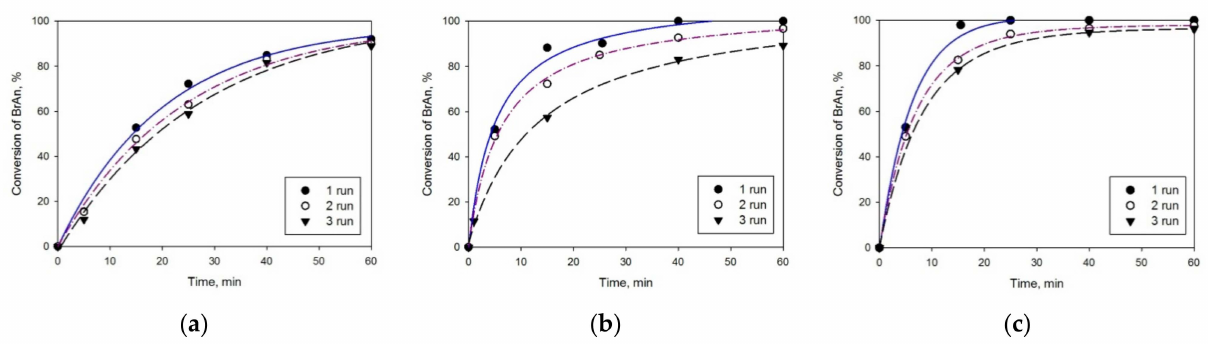
Figure 11. Influence of repeated runs on the dependence of BrAn conversion vs. time for 1%-Pd/HPS- R ( a ), 0.5%-PdAu/HPS-R ( b ), and 1%-PdAu/HPS-R ( c ): 1 mmol of BrAn, 1.5 mmol of PBA, 1.5 mmol of NaOH, 60 ◦ C, 900 rpm, and 30 mg of